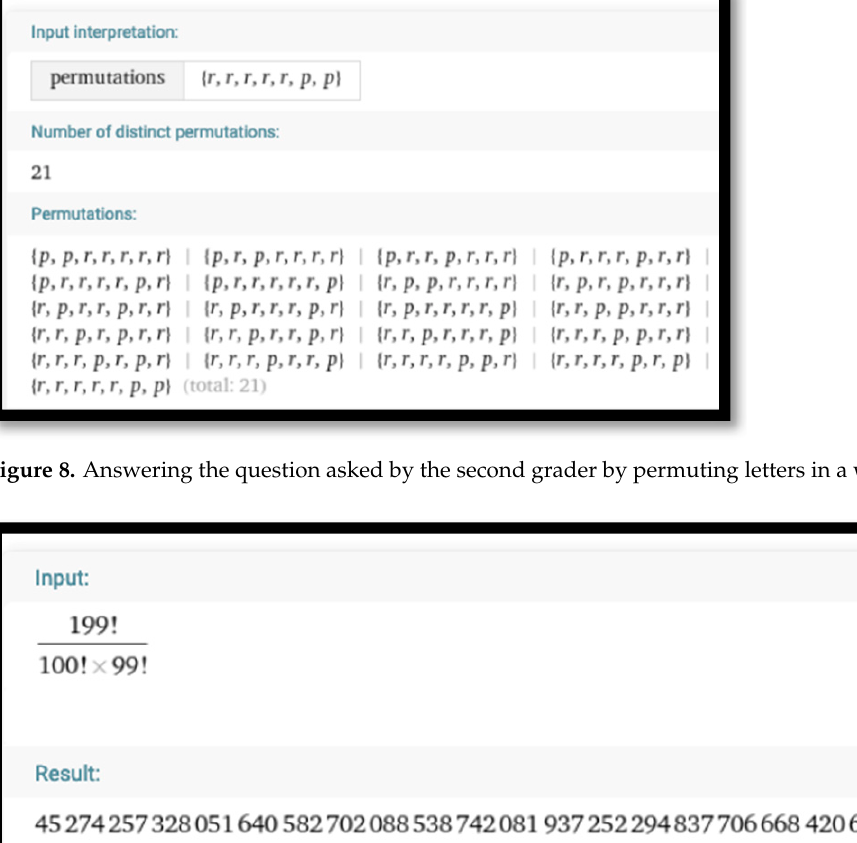
Figure 9. Computing the number of ways to place 100 rings into a 100-section box.